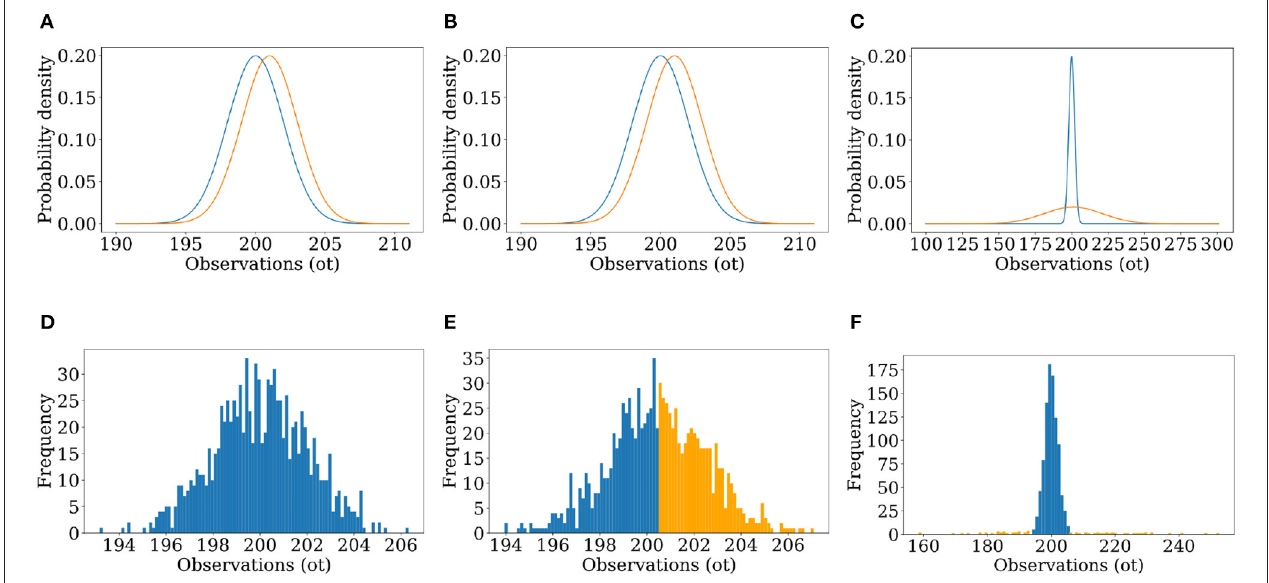
FIGURE 3 | (A–C) Graphs of the distributions used to generate the observations of the simulated world and used by the simulated observer to find the likelihood, for unimodal Trials 1–3. (D–F) Results of Trials 1–3, showing a histogram of the 1,000 observations of the simulated world colored by the result of classification (blue for classified as real, orange for classified as false).